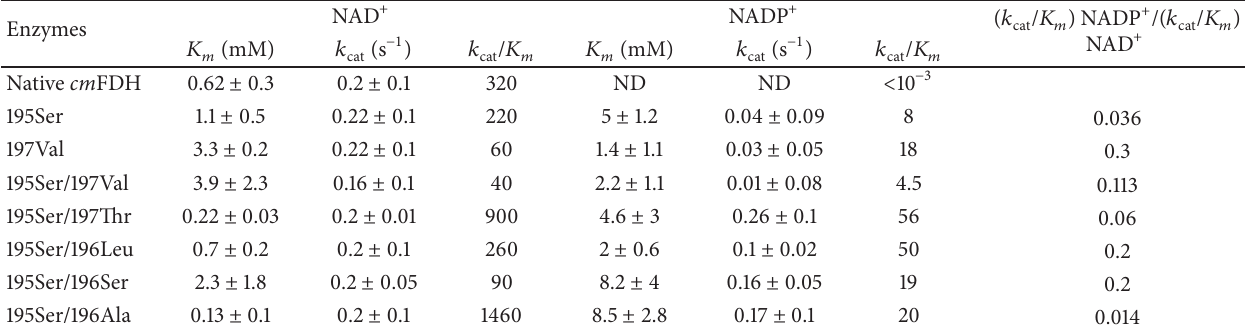
Table 1: The kinetic parameters of wild-type cm FDH and